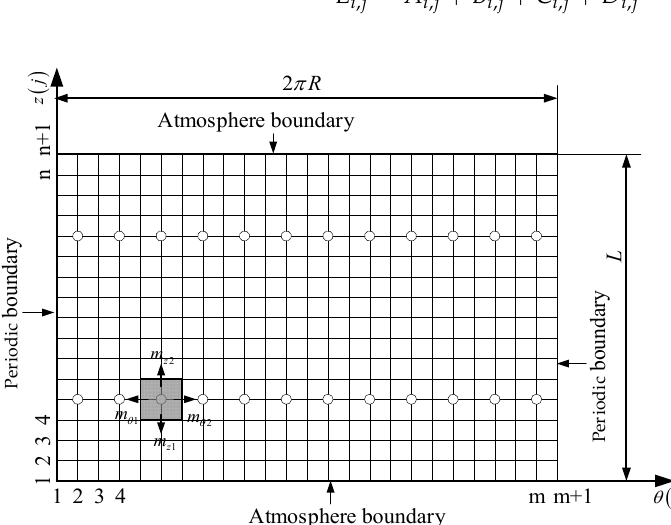
Figure 2. Finite different mesh of journal bearing. According to conservation of mass, the mass inflow rate through an orifice must reach equilibrium within the neighborhood around this orifice as shown in Figure 2. The mass outflow rate can be calculated by [26].